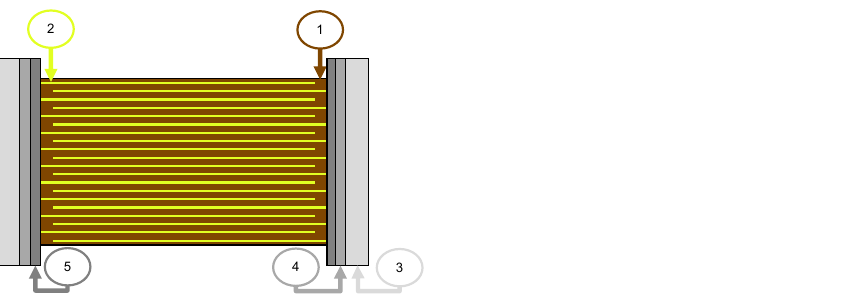
Figure 1. Typical structure of a multilayer ceramic chip capacitor (MLCC) with: (1) ceramic dielectric layers, (2) inner electrode layers and (3, 4, 5) termination electrodes. The termination electrodes consist of: (5) a substrate layer for connecting the termination to the inner electrodes, (4) a barrier layer as thermal protection of the dielectric from soldering and an external layer (3) for soldering the MLCC .